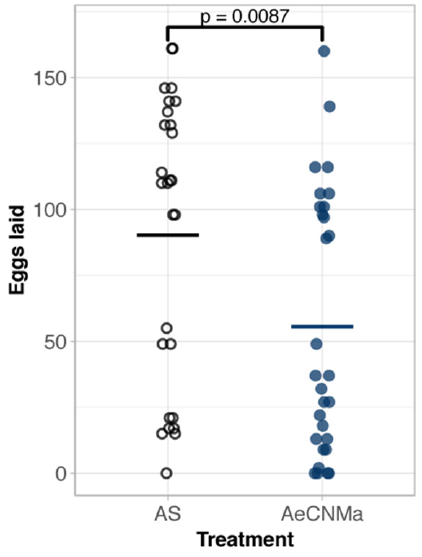
Figure 5. AeCNMa reduces egg clutch size in mated Ae. aegypti females. Age-matched females were blood fed on an artificial membrane feeding apparatus and immediately injected with CNMa or Aedes saline (AS). After three days females were allowed to oviposit and eggs were counted 48 h later. Points represent individuals and bar represents mean. Females injected with AeCNMa produced significantly fewer eggs than controls ( p = 0.0087, Wilcoxon rank-sum test).